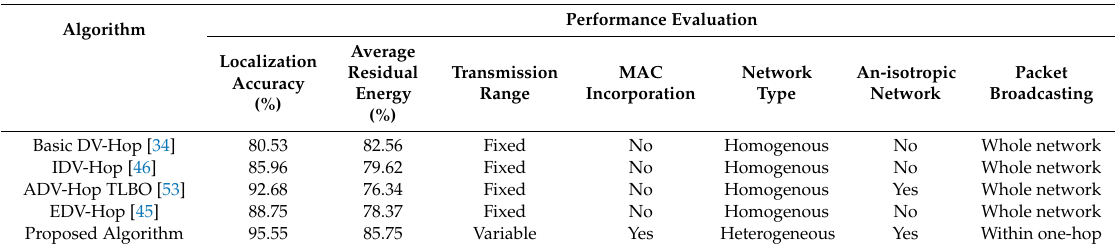
Table 6. Comparison of di ff erent performance